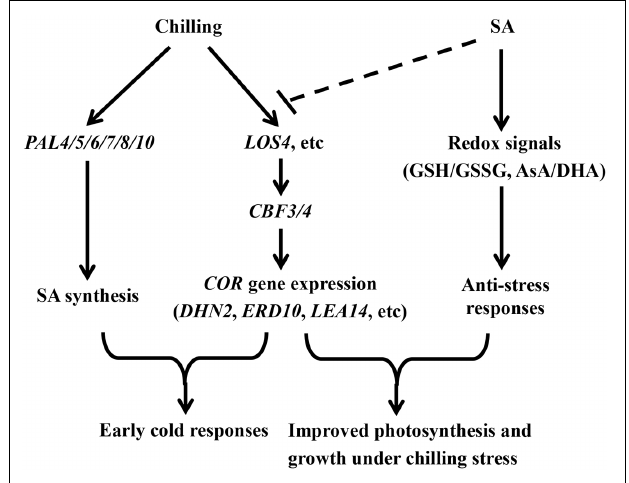
FIGURE 9 | A proposed model for SA-induced chilling tolerance in coordination with CBF-responsive pathway in watermelon